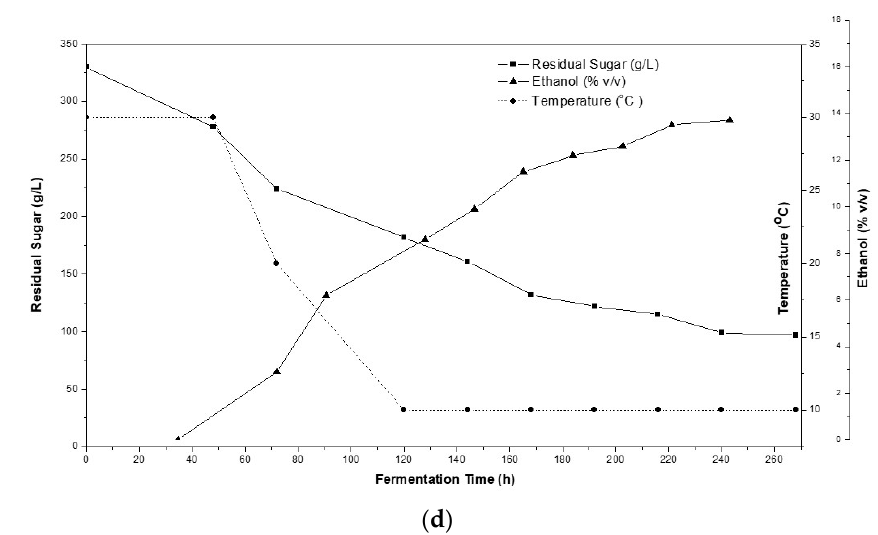
Figure 2. Kinetics of the sweet wine fermentation using freeze-dried raw materials after no storage time ( a ), storage for 30 days ( b ), storage for 60 days ( c ) and storage for 90 days ( d ) at room temperature (20–22 °C).